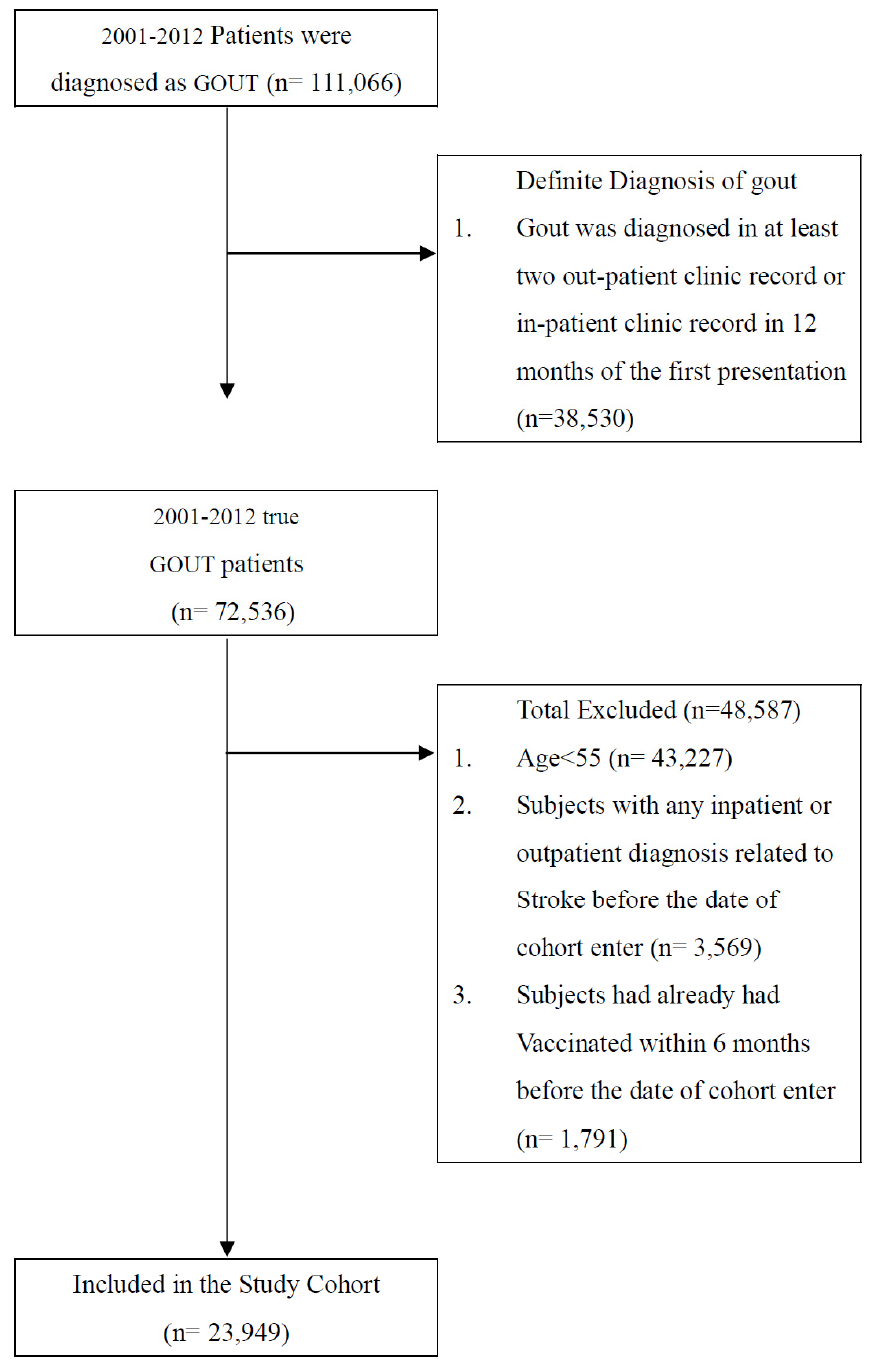
Figure 1. Data selection process.